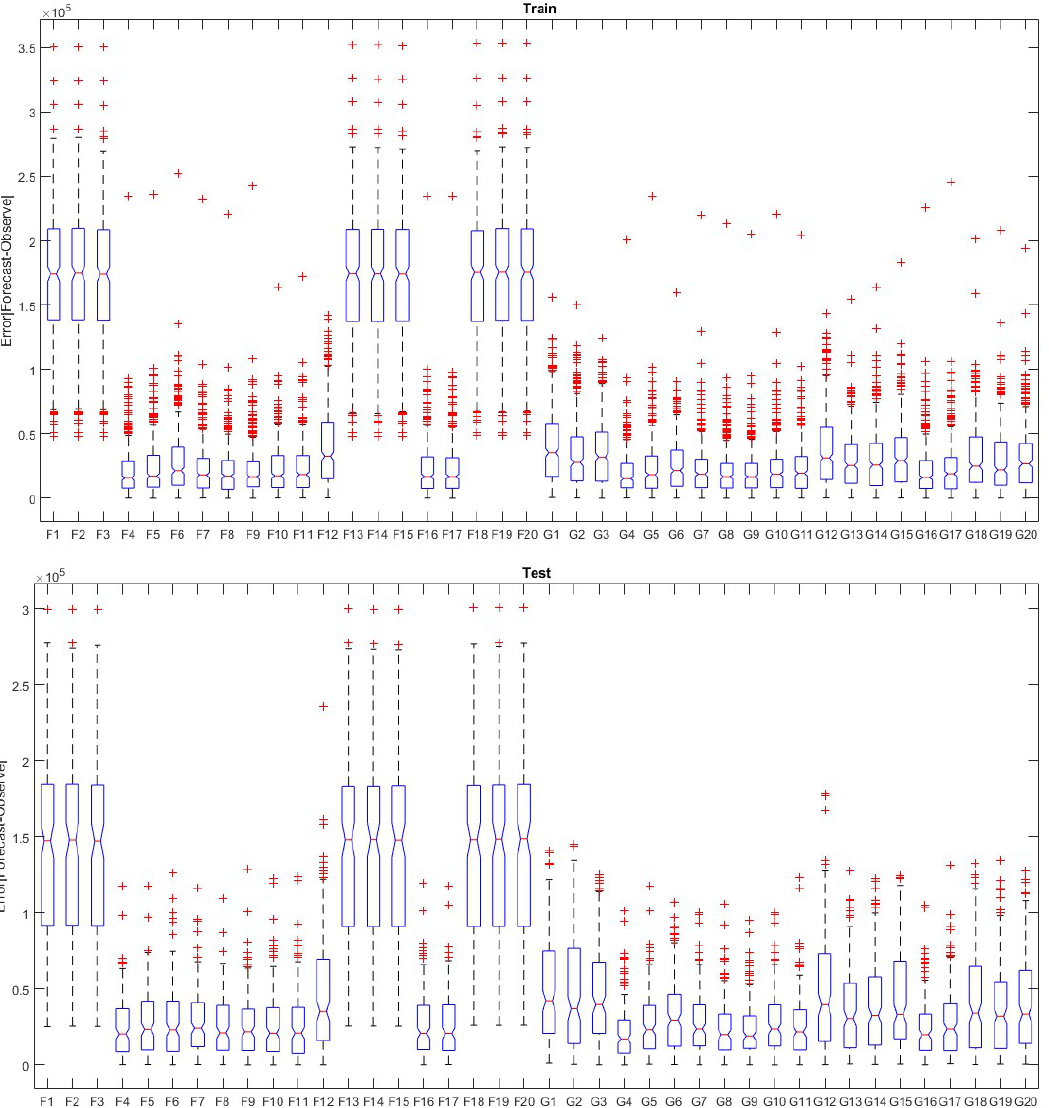
Figure 8. Box plot of errors for ANFIS and GWO-ANFIS modeling in training and testing phases. F and G refer to ANFIS and GWO-ANFIS, respectively.